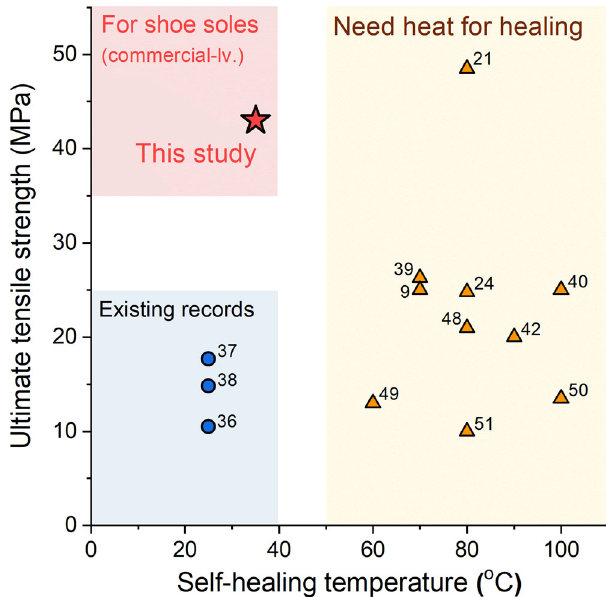
Fig. 2 Ashby plot of ultimate tensile strength versus self-healing temperature of C-IP-SS and other elastomers reported in literature. The red star indicates the properties of C-IP-SS. The blue circles indicate the properties of the reported autonomously self-healing elastomers without external stimulus. The yellow triangles indicate the properties of the reported elastomers that need heat for healing.